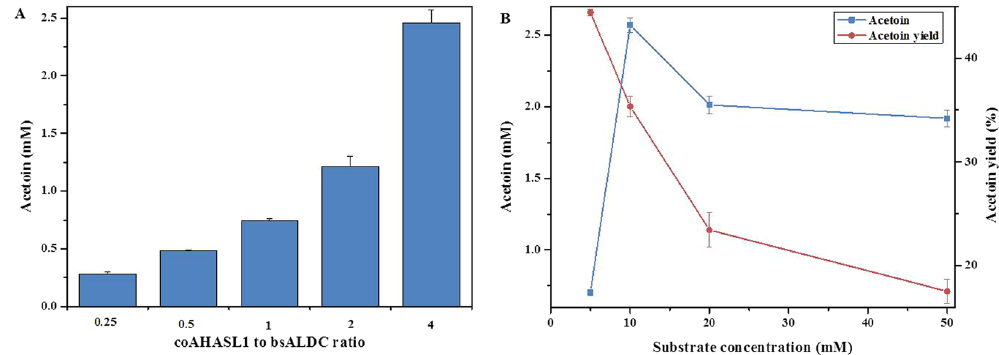
Figure 4. Optimization of the cell-free biosynthetic system. ( A ) Effect of the enzyme loading ratio on acetoin synthesis. Determination of the effect of the enzyme ratio on the synthesis of acetoin was tested in a total enzyme loading of 0.1 U mL − 1 with 10 mM pyruvate. The ratio between coAHASL1 and bsALDC was changed from 0.25 to 4. ( B ) Effect of substrate loading on acetoin synthesis. Determination of the effect of the substrate concentration on the synthesis of acetoin was carried out by changing the concentration of sodium pyruvate from 5 to 50 mM. The total enzyme (coAHASL1/bsALDC 4:1) was applied at a ratio of 1 U/10 mM substrate. All reactions were conducted at 65 °C in citrate-phosphate buffer (pH = 6.5) for 12 h. Error bars indicate standard deviations of three independent experiments.